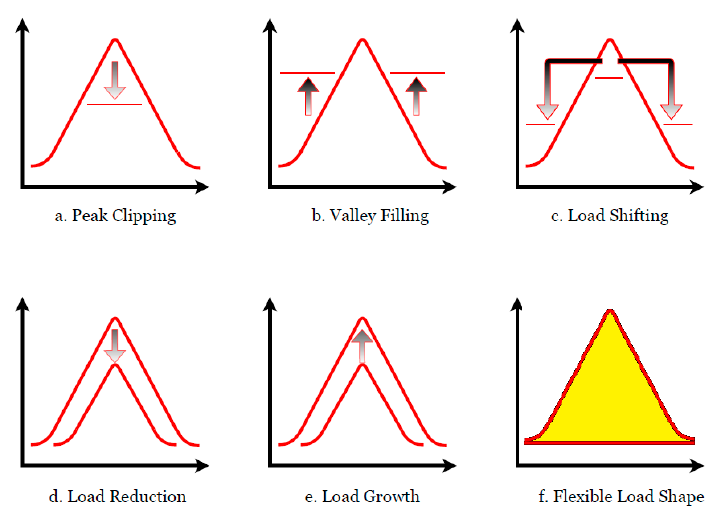
Figure 5. Methods of Demand Side Management.